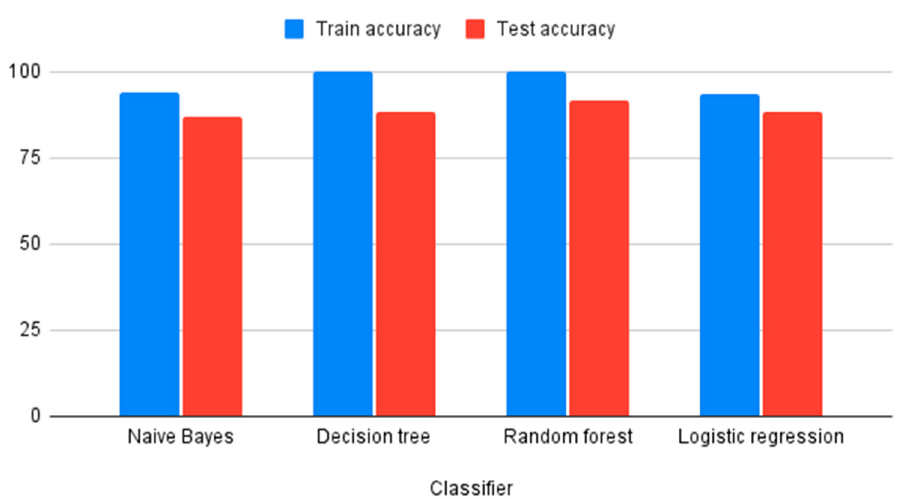
Figure 24. Accuracy plot of comparative analysis (Training vs Testing).